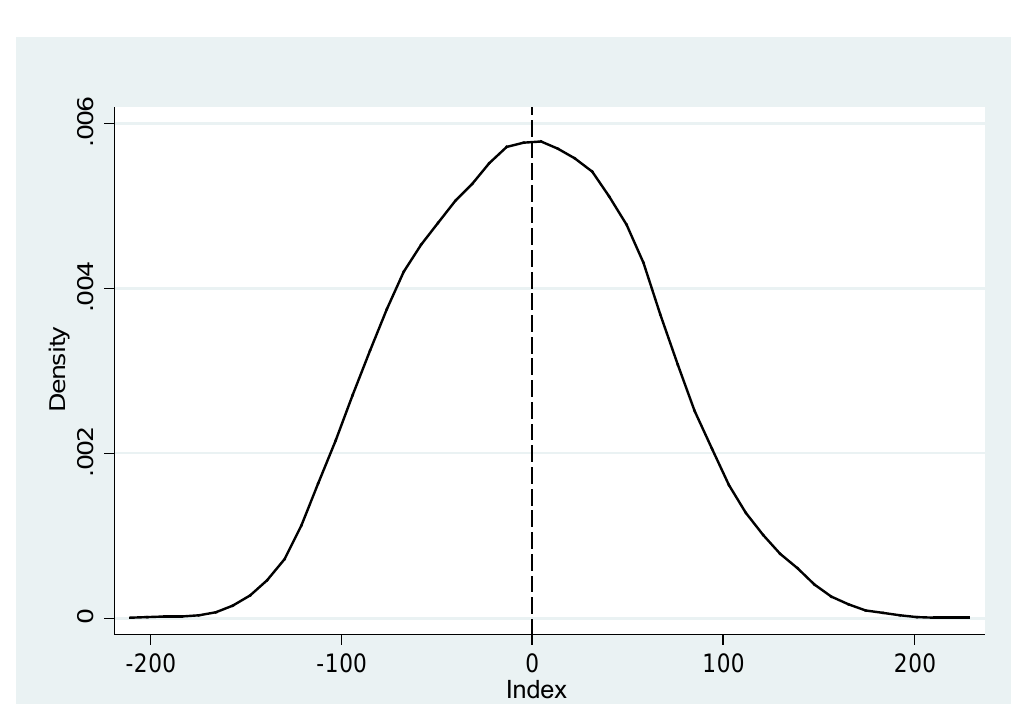
Figure S1: Distribution of lowest recentered 2011 ELA and Mathematics CST scores (“Index”), 2011-12 Live Oak and Mann